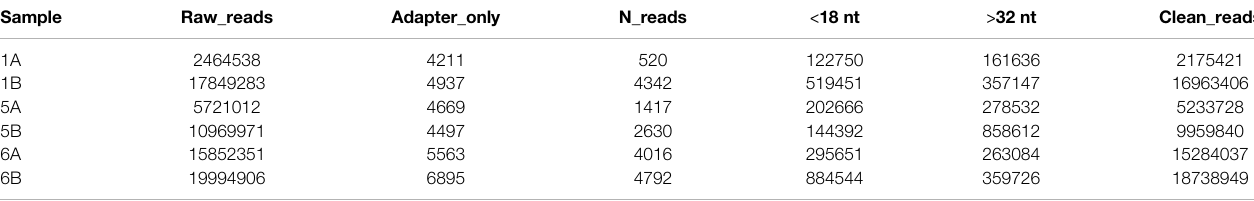
TABLE 1 | Raw data statistics of miRNA